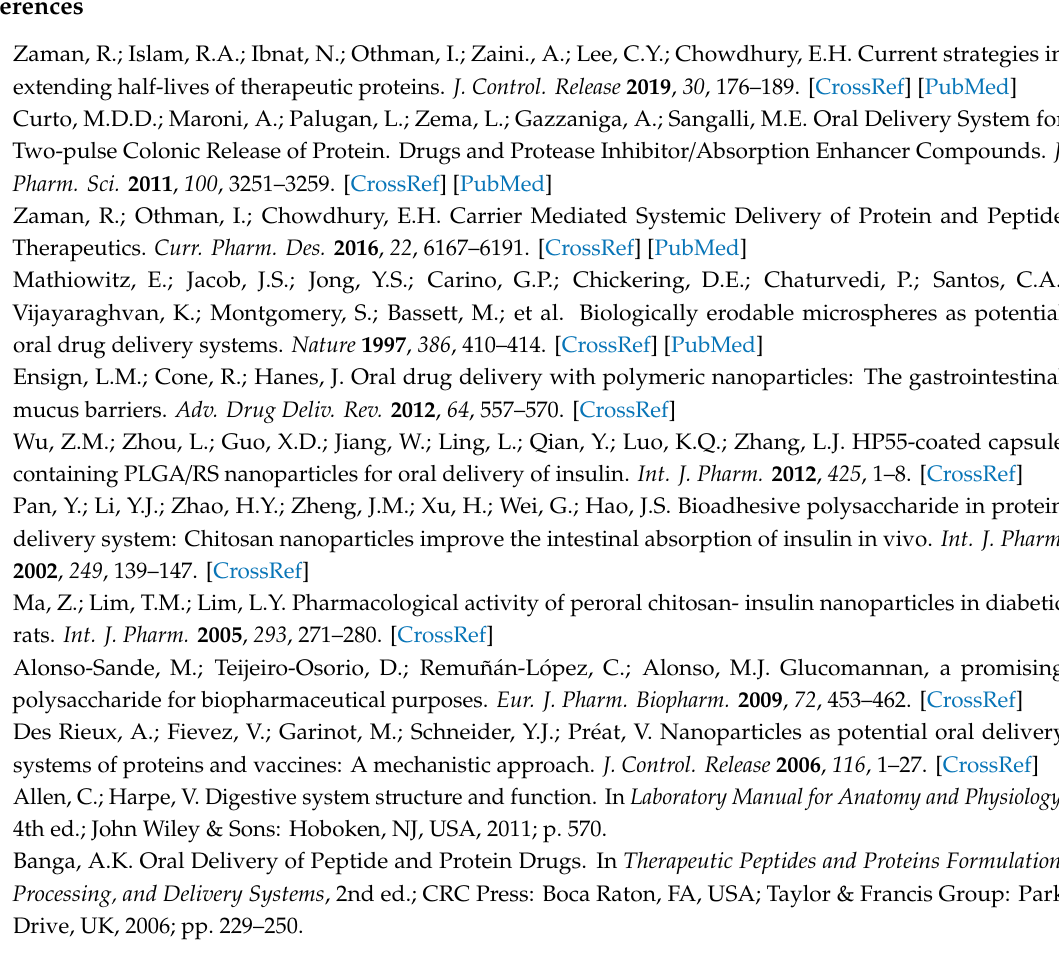
s1, supplementary Figure S1: Standard curve generated with data from free FITC-Insulin amount vs.